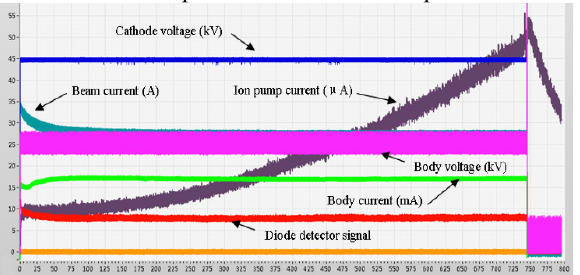
Fig. 7. The waveforms of the 650W 753s pulse of the #1 gyrotron.